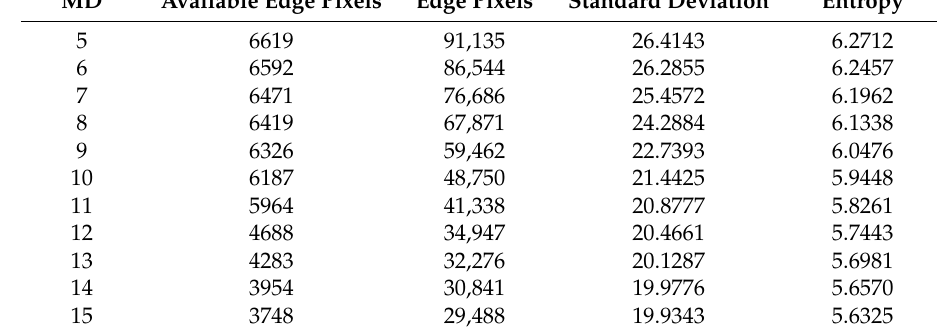
Table 7. The values of standard deviation, entropy, available edge pixels and edge pixels corresponding to the values of different parameter MD.